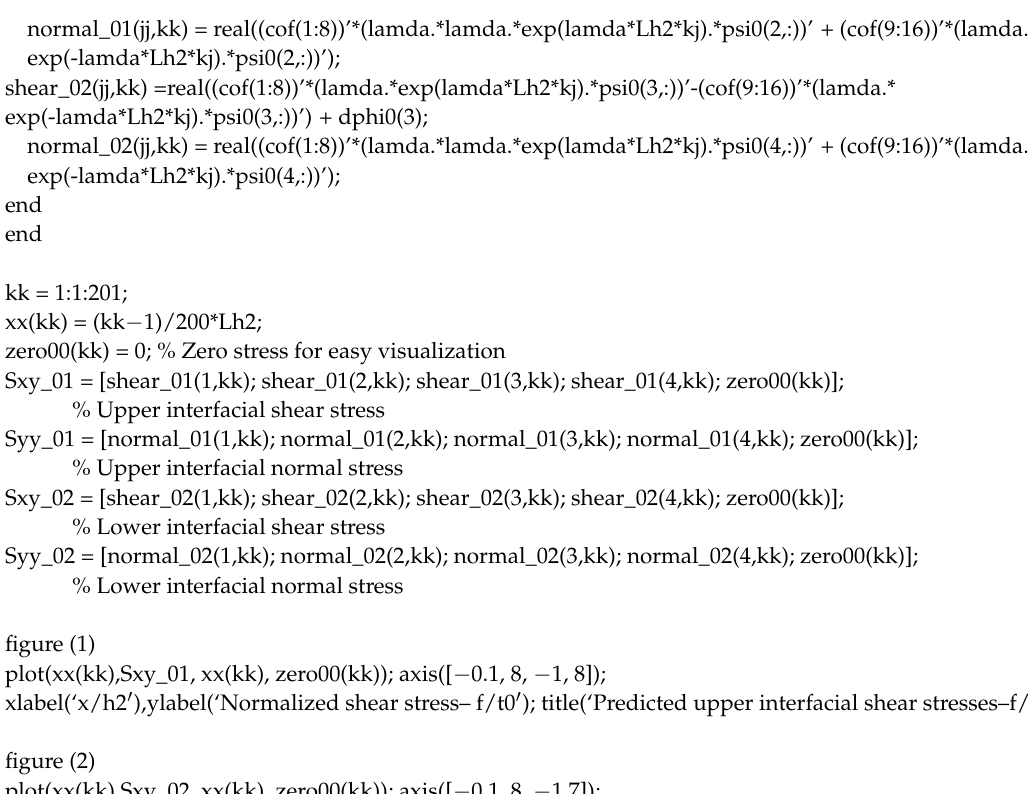
figure (2) plot(xx(kk),Sxy_02, xx(kk), zero00(kk)); axis([ − 0.1, 8, − 1,7]);